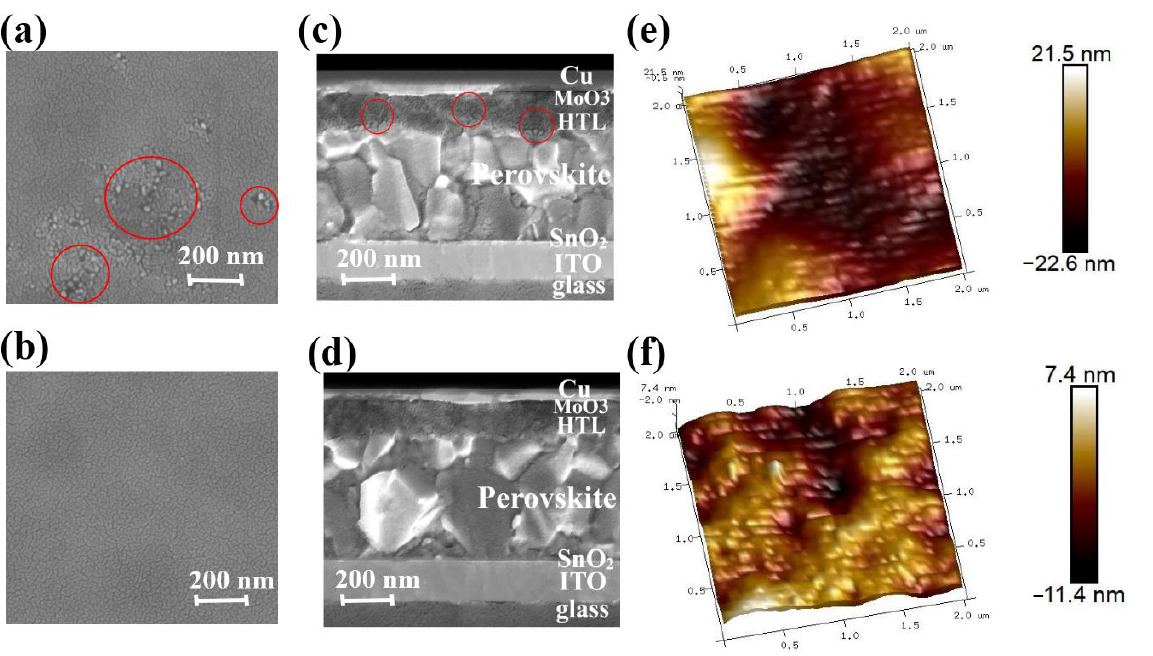
Figure 2. Top-view SEM images of Spiro-OMeTAD film oxidized at room temperature for 8 h HTL 0.0 wt% ( a ) and HTL 0.4 wt% ( b ). Cross-sectional SEM images of PSCs based on HTL 0.0 wt% ( c ) and HTL 0.4 wt% ( d ). 3D AFM images of HTL 0.0 wt% ( e ) and HTL 0.4 wt% ( f ). Films for the AFM testing in tapping mode. The red circles in panels ( a ) and ( c ) represent the aggregated regions of the Spiro-OMeTAD